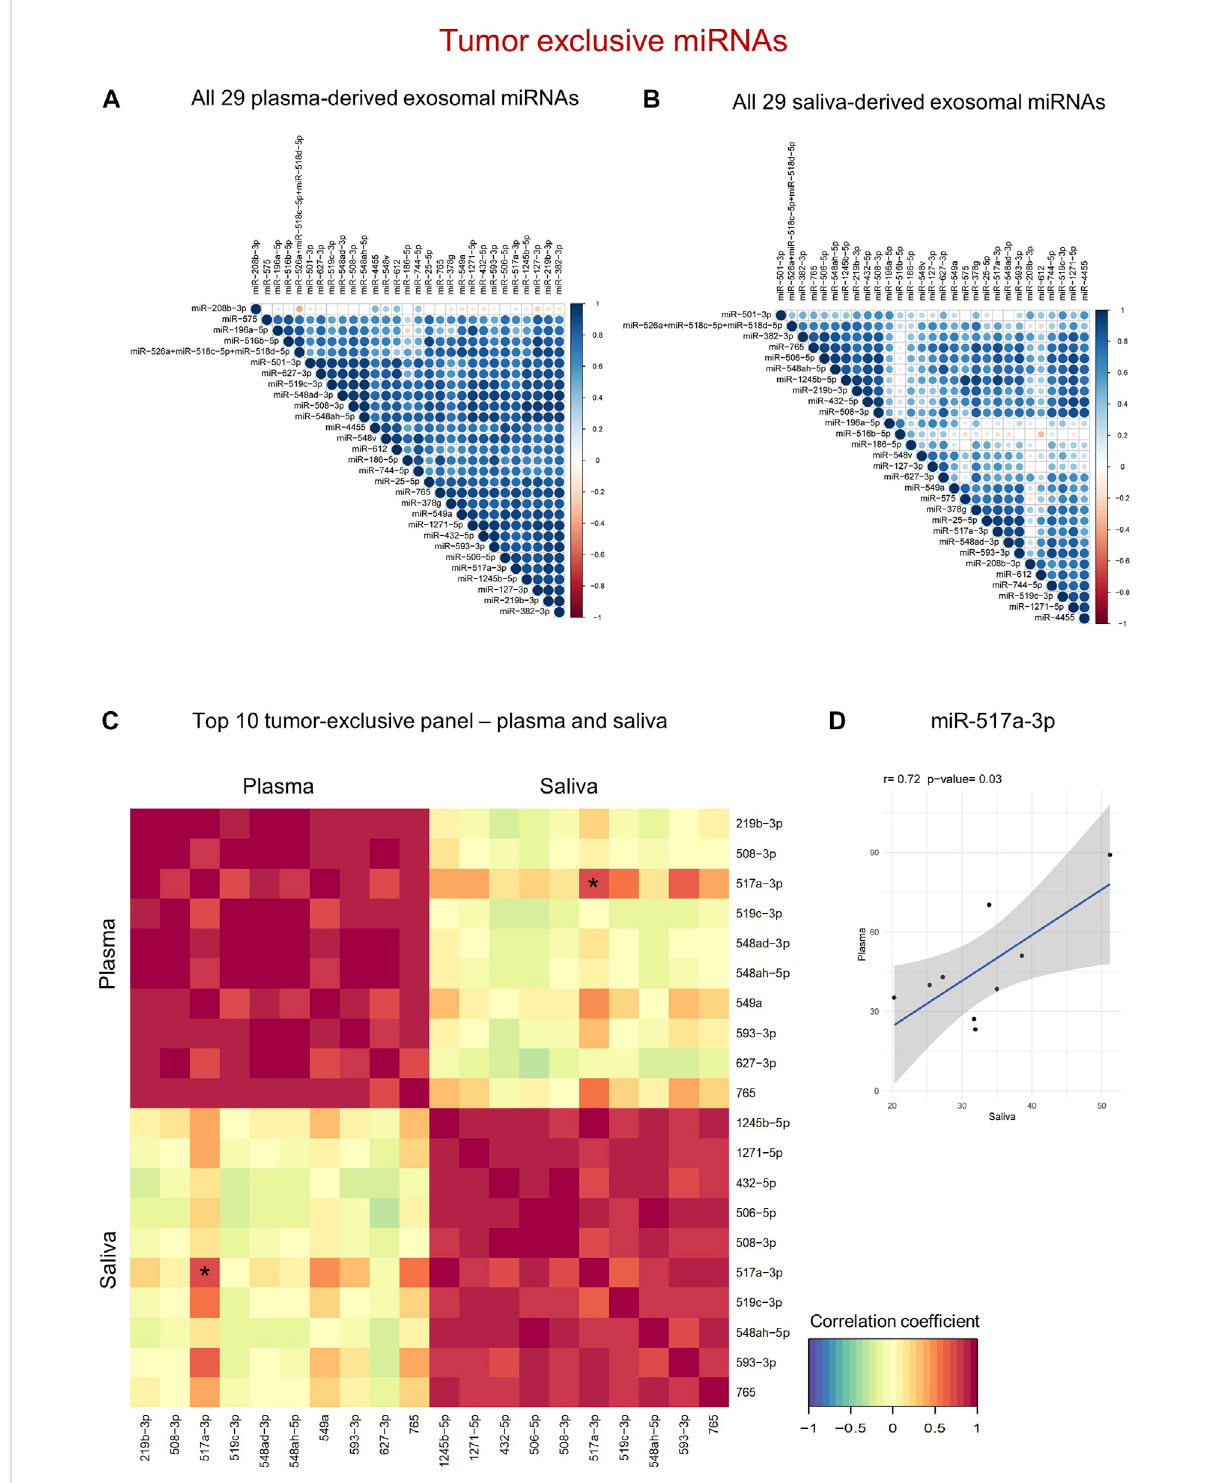
FIGURE 5 Tumor-exclusiveexosomalmiRNAsrevealdiagnosticpotential inbothplasmaandsaliva. (A,B) Correlationmatrixoftumor-exclusiveexosomal miRNAs from plasma (A) and saliva (B) . The stronger the color (blue = positive, red = negative correlation) and the bigger the circle, the higher the correlation between individual miRNAs. (C) N-integration correlation matrix that re fl ects intra- and inter-correlation within and between the two diagnostic panels. Red = Positive correlation, yellow = no correlation, green = negative correlation. The asterisk marks the only miRNA with signi fi cant inter-correlation, which is further shown in (D) . (D) Scatter plot showing normalized counts of miR-517a-3p with signi fi cant positive correlation between plasma and saliva of individual HNSCC patients as determined by Pearson ’ s correlation